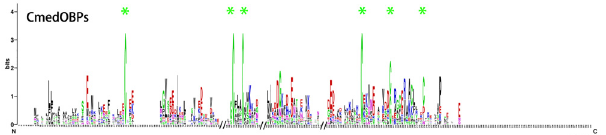
Fig 4. CmedOBPs sequence logo. Degree of amino acid sequence conservation along the primary sequence axis of C . medinalis odorant-binding proteins (OBPs). Depicted amino acid character size correlates to relative conservation across aligned sequences. Green asterisks indicate the conserved six cysteine motifs characteristic of OBPs.